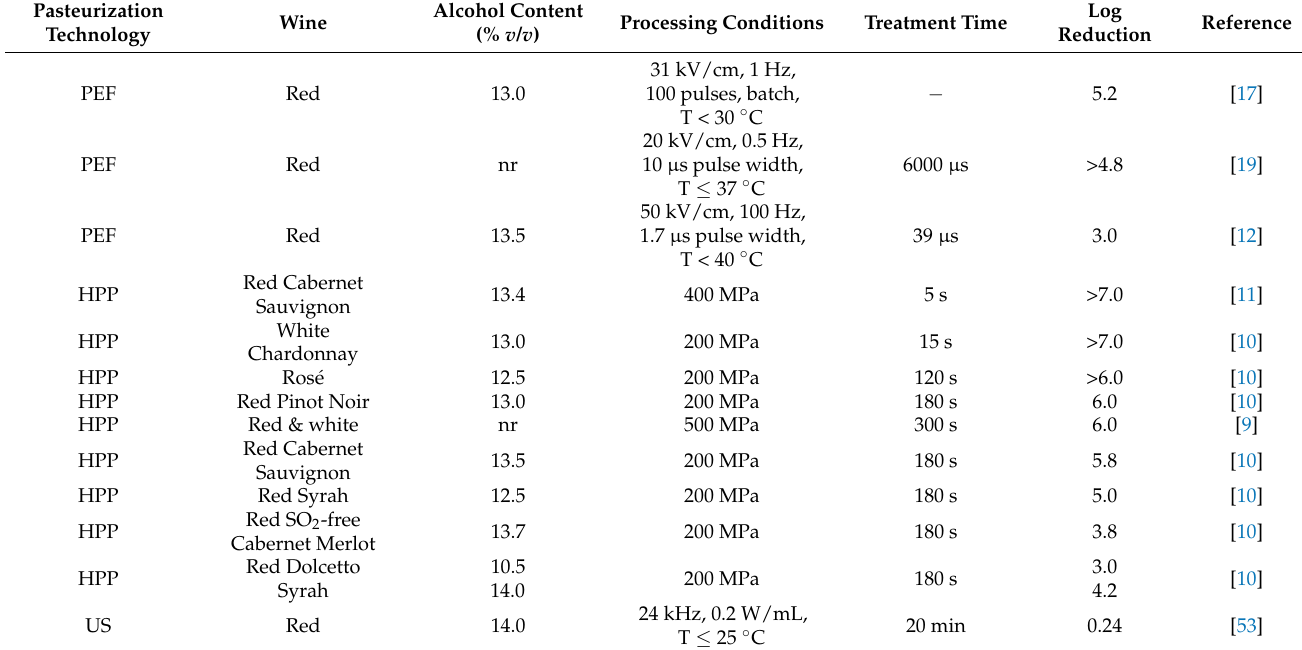
Table 1. Inactivation of Brettanomyces bruxellensis yeast in wine by non-thermal PEF, HPP and US technologies *. Pasteurization